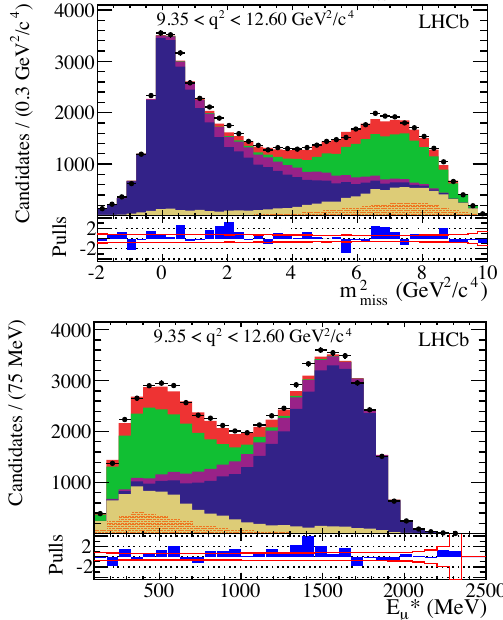
Figure 2: Distributions of m 2 (up) and E ∗ (down) in the highest µ miss q 2 bin of the selected data sample, overlaid with the projections of the fit model. The signal component is drawn in red, while the normalisation in blue. Background components of the selected samples are the doubly charmed decays, H b → H c H c ( → (cid:96)τ X ), in green, the B → D ∗∗ (cid:96)ν decays in violet, combinatorial and misidentified muons in light and dark yellow,